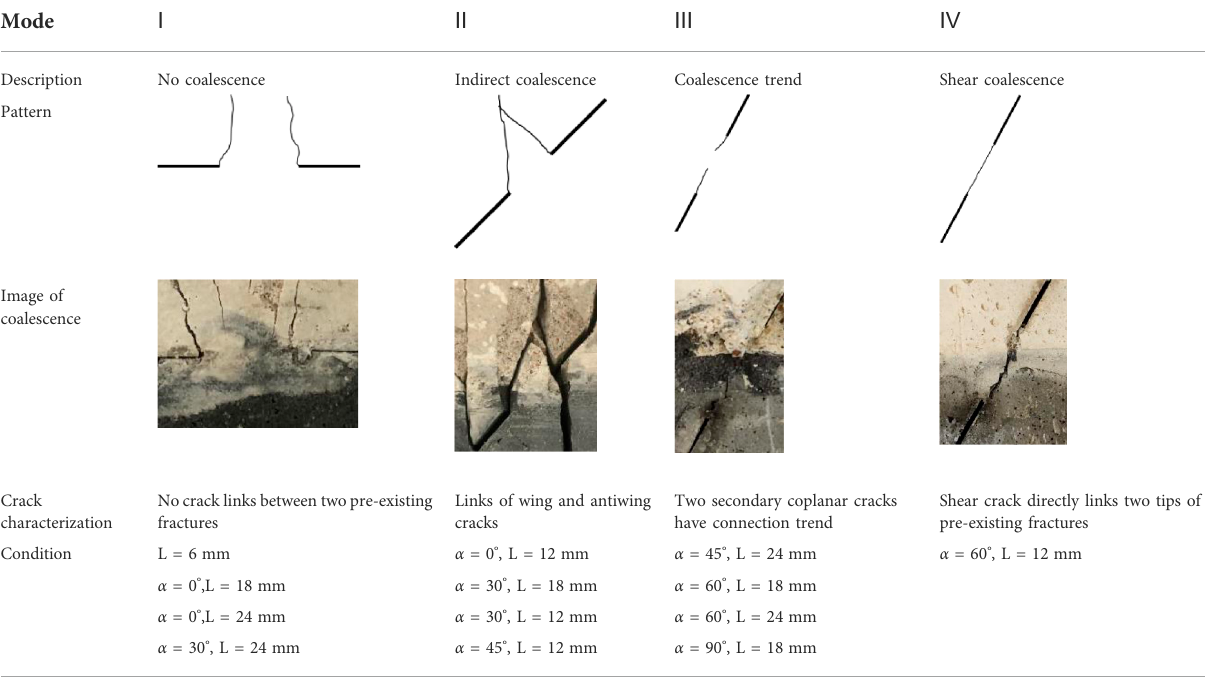
TABLE 5 Four typical modes of rock bridge coalescence in composite rock with coplanar fracture.